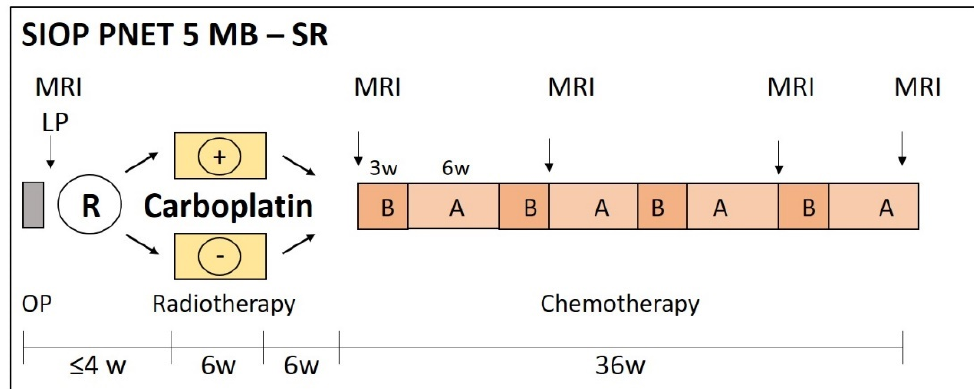
Figure 1. Therapy overview SIOP PNET5-LR stratum. After surgery (OP), patients receive 18.0 Gy craniospinal radiotherapy followed by a boost to 54.0 Gy to the tumour bed. Subsequently, patients receive six cycles of chemotherapy, alternating B (cyclophosphamide 1000 mg/m 2 /d i.v. days 1 and 2 with mesna, vincristine 1.5 mg/m 2 /d day 1, continue with the next block day 22) with A (cisplatin 70 mg/m 2 /d day 1, lomustine 75 mg/m 2 /d day 1 and vincristine 1.5 mg/m 2 /d days 1, 8 and 15, continue with next block day 43).